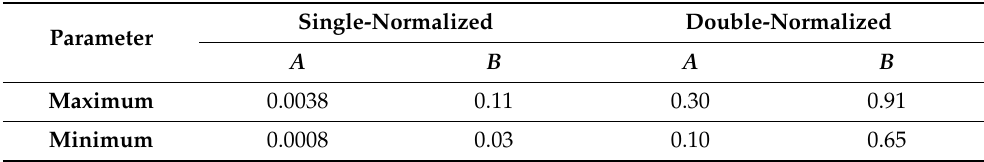
Table 6. Maximum and minimum values of very dense